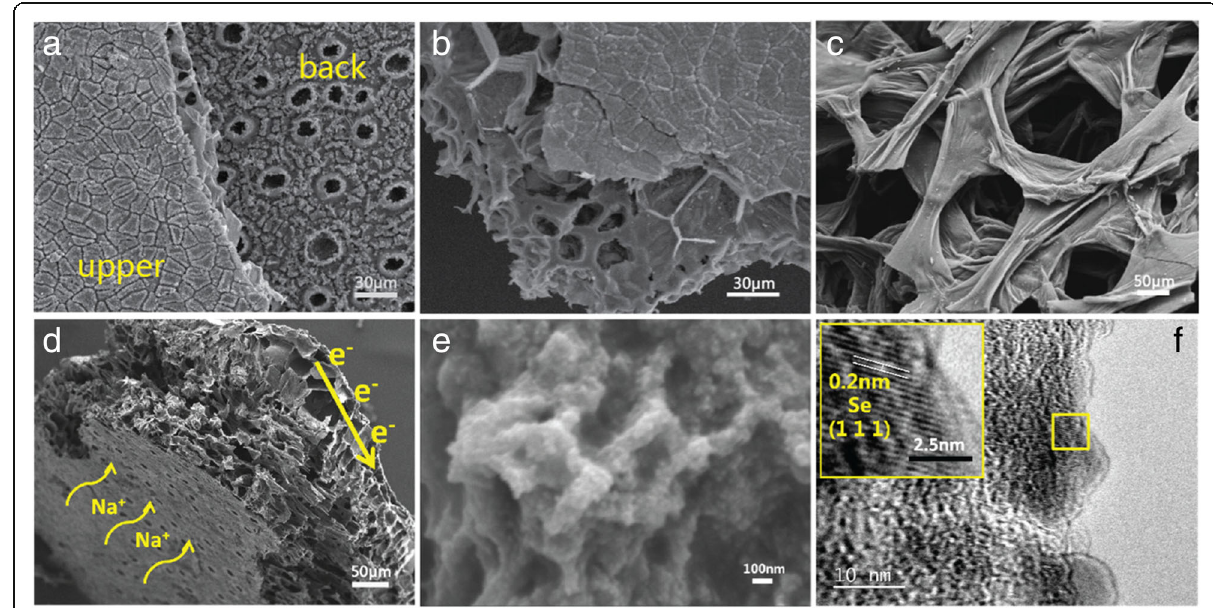
Fig. 2 SEM images of the R800 a upper surface and back surface and b cross-sectional view. c Magnified SEM image of the carbon sheet in the sponge layer of the R800A. d FESEM image of the cross section. e Magnified FESEM image. f HRTEM image of the Se-R800A